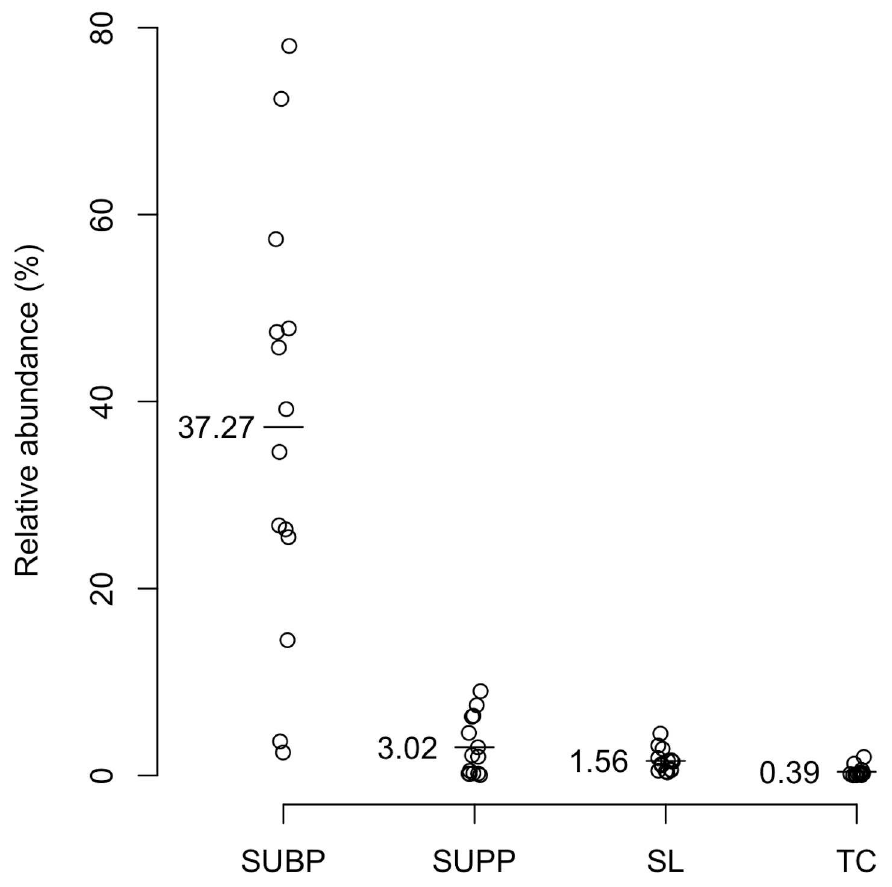
Fig 2. Total relative abundances of the 12 SUBP-specific OTUs in the pre-therapy samples from each niche. The mean relative abundance in each niche is representedby a line and a number.